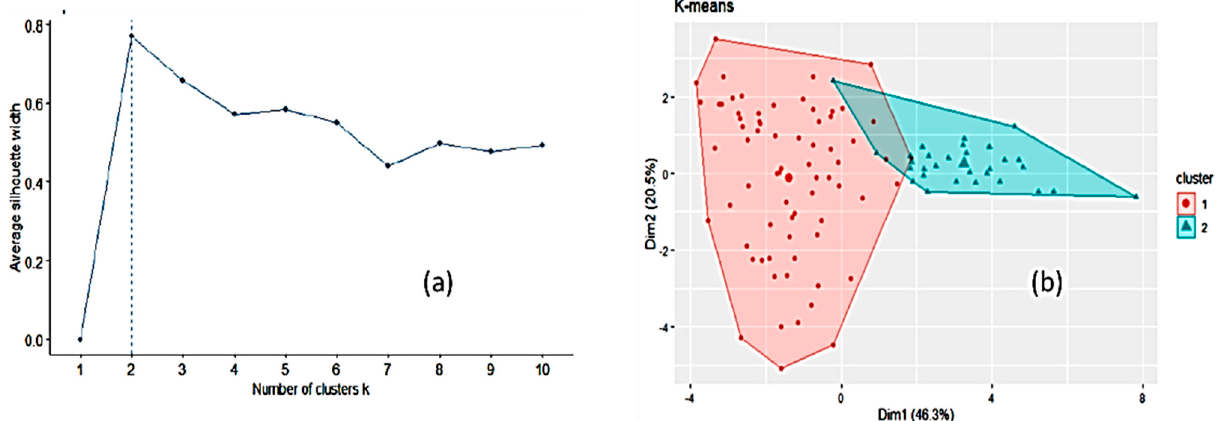
Figure 3. Optimal number of clusters by k-means using the average silhouette width ( a ) and clustering of honey samples by k-means algorithm in two clusters where the two largest symbols are the centroids of each cluster ( b ). Table 1. Model optimization using the classifier algorithms. Log loss values are means of 10-fold